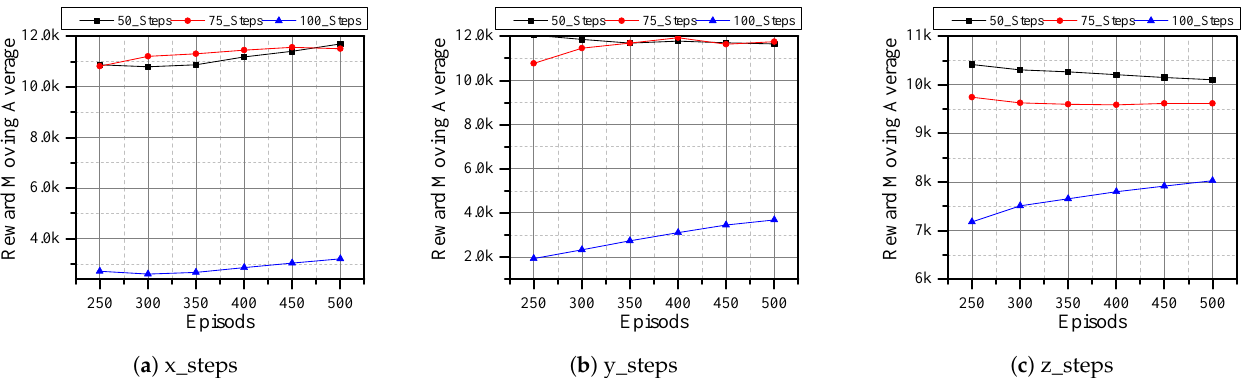
Figure 8. DQN and Adadelta optimizer with steps/episode varying for a total of 500 episodes using MSE reward